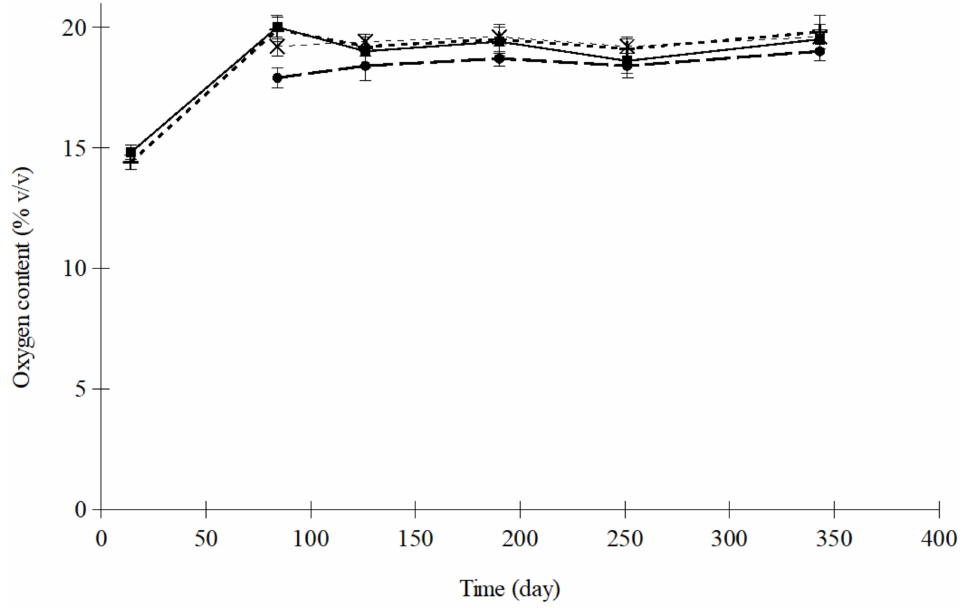
Figure 2. Evolution of O 2 concentration in trays containing raisins sealed with polyamide/polypropylene (PA/PP) 20/75 film and flushed with N 2 ( × , 5 ◦ C; (cid:4) , 15 ◦ C; +, 25 ◦ C; • , 35 ◦